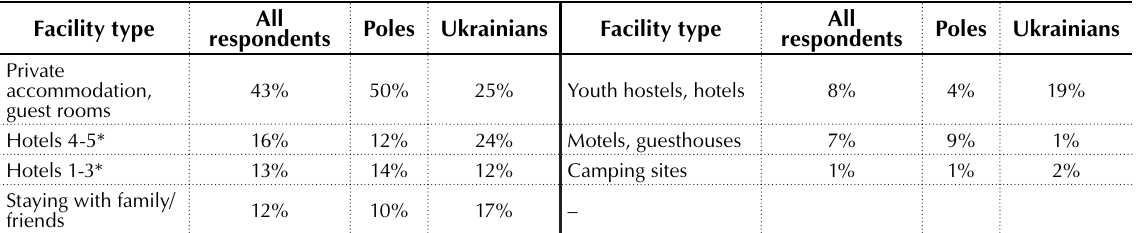
Table 2. The most frequently used facilities offering accommodation